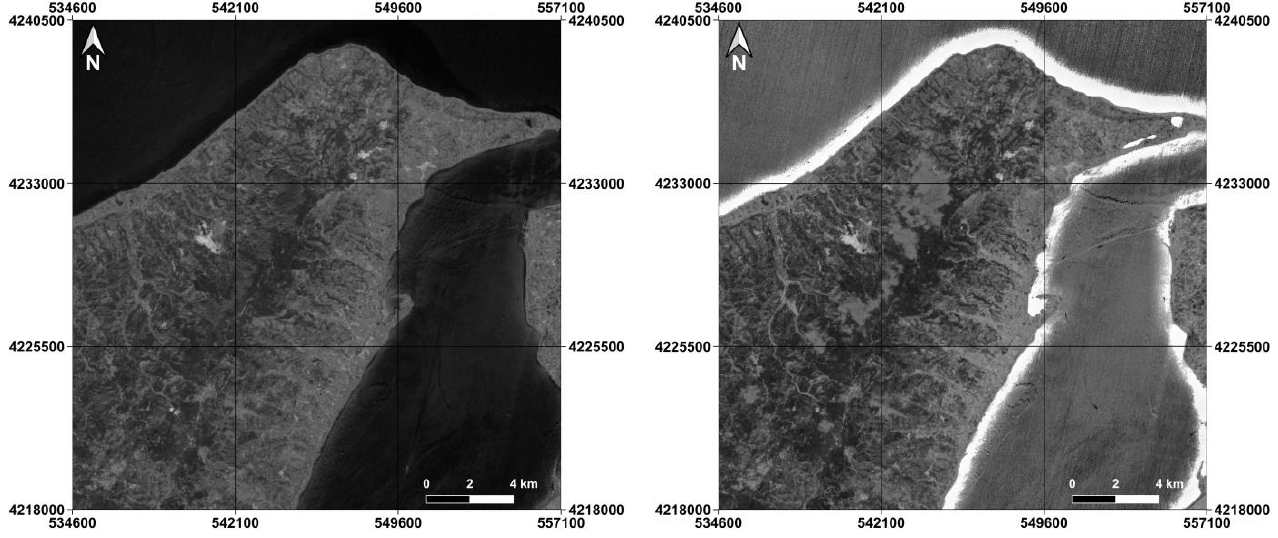
Figure 5. Comparison between NBR+ ( left ) and NBR ( right ) post-burn.